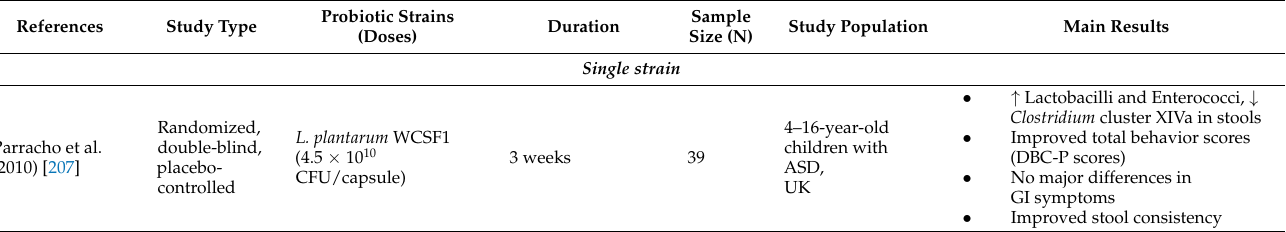
Table 2. Clinical studies of probiotic and synbiotic supplementation in children with